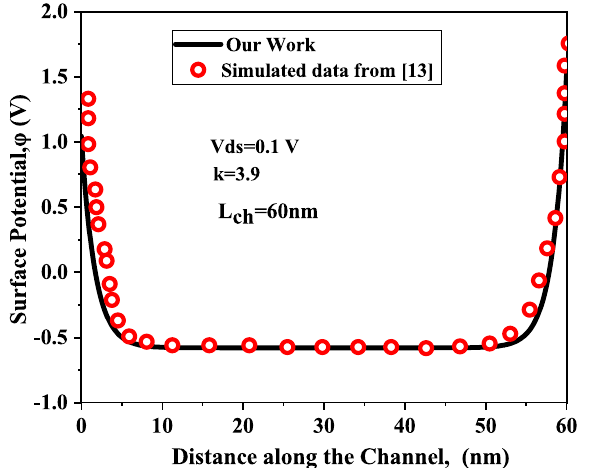
Figure 5. Surface potential calculated using our proposed model vs. quantum simulated data of 23 for V gs = 1 V .